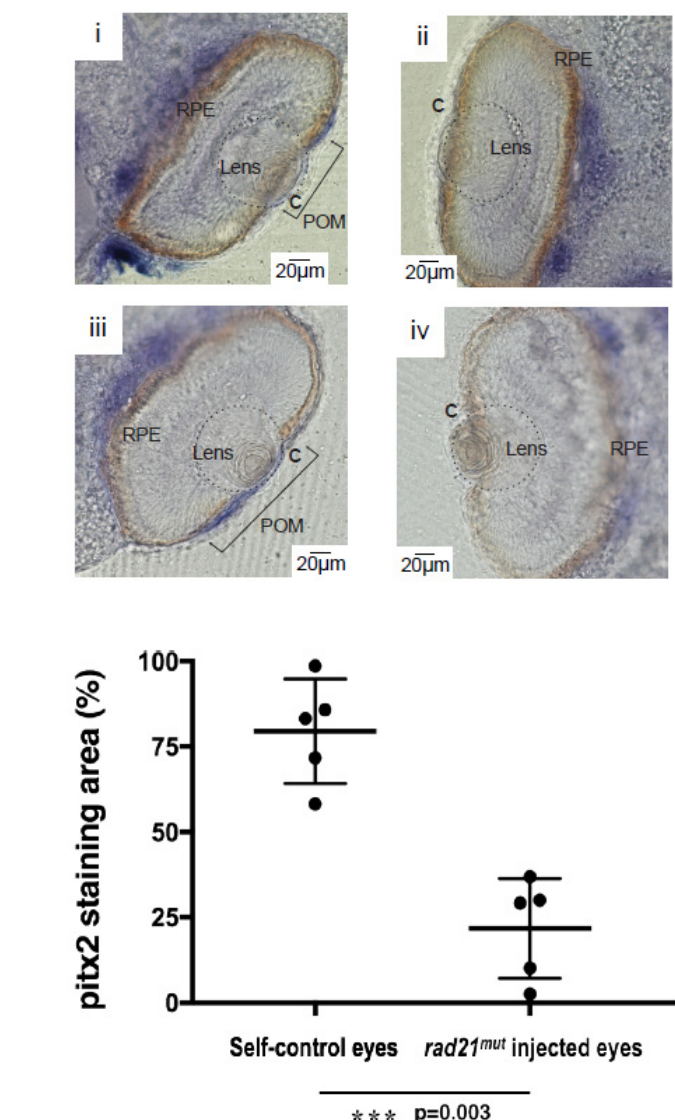
Figure 4. The expression of pitx2 was decreased by injecting rad21 mut into X. laevis embryos. The transcription factor pitx2 is highly abundant in periocular mesenchymes (POM) and was used as a marker of POM. The lens is indicated by a dash circle. ( a ) Panel i and iii show the in situ hybridization expression pattern of pitx2 (blue) in the non-injected side of two X. laevis embryos at stage 41. The other sides of all five embryos (5/5) injected with rad21 mut mRNAs showed a lack of pitx2 staining in the cornea (C) area (panel ii and iv). Normal structures of lens and retina layers could be observed in both the non-injected and the rad21 mut - injected sides. ( b ) The quantification of pitx2 -positive areas in the non-injected control eyes and the rad21 mut -injected eyes was done using ImageJ. *** A significant decrease of staining corresponding to 57.7% was detected ( p = 0.003).